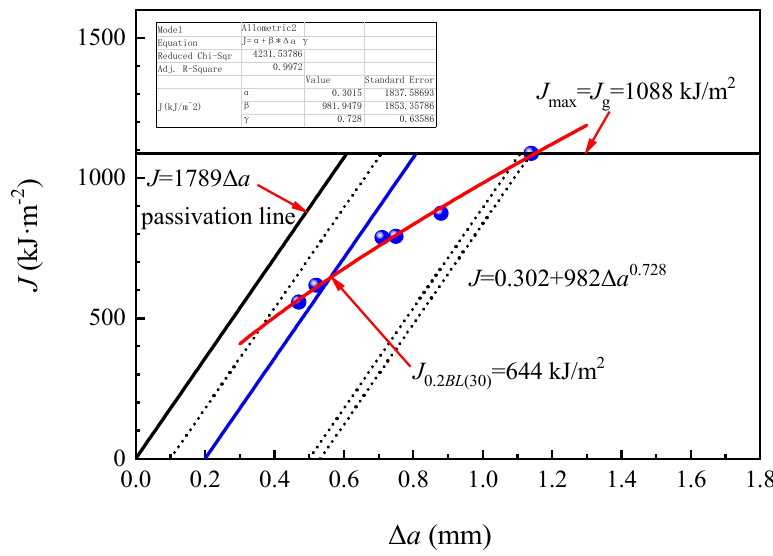
Figure 11. J - ∆ a resistance curve of E36 steel plate. Figure 11. J - Δ a resistance curve of E36 steel plate. The fracture toughness K J 0.2 BL (30) of EH36 and FH36 steel plates was